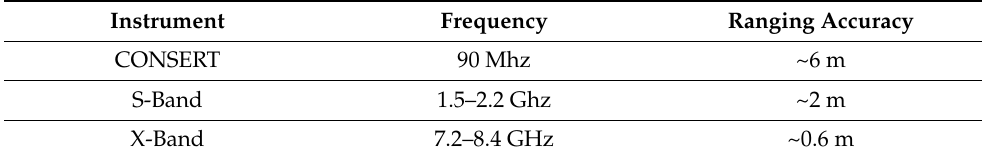
Table 1. Typical ranging accuracy for CONSERT, S-band and X-band signals from DSN tracking antennas [27,31,32]. Instrument Frequency Ranging Accuracy CONSERT 90 Mhz